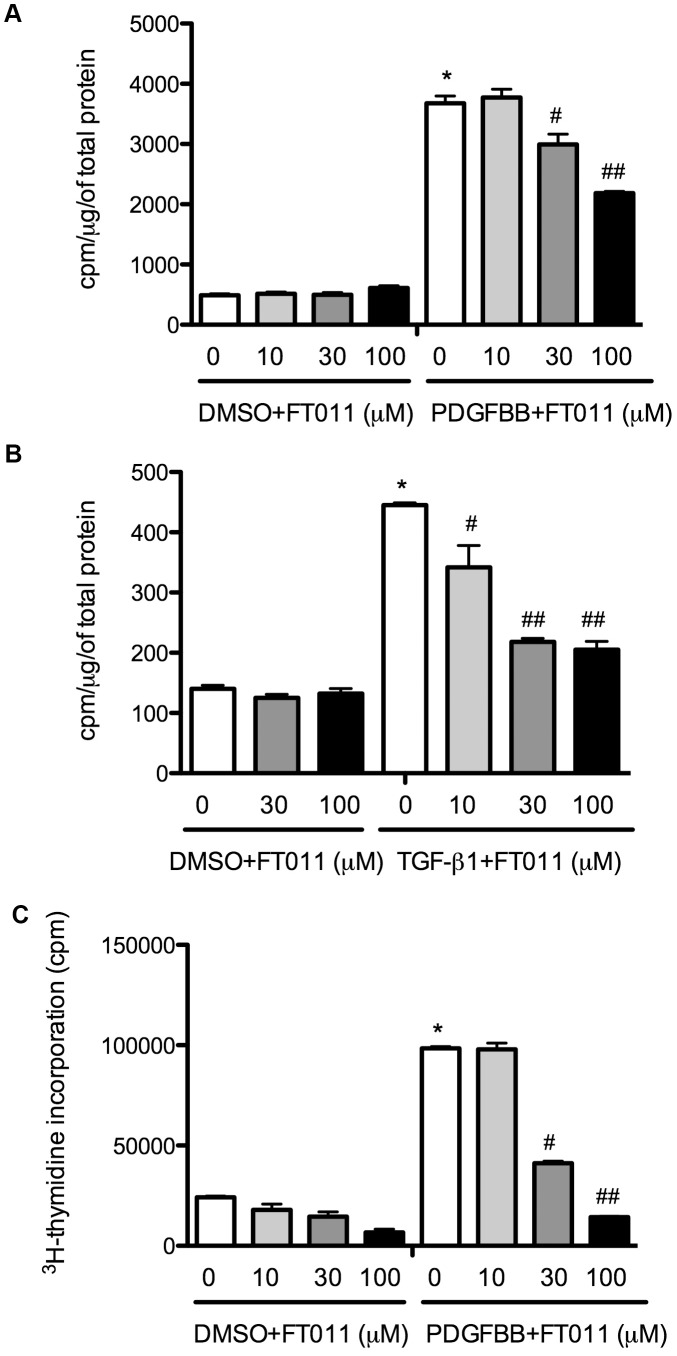

3H-proline and 3H-thymidine incorporation.PDGF BB (Figure 1A) or TGF-β1 (Figure 1B) stimulated collagen production in cultured mesangial cells with and without FT011 treatment as assessed by 3H-proline incorporation. Data are expressed as mean ± SEM. *p<0.001 versus DMSO with or without FT011 (10, 30 or 100 µM), #
p<0.01 versus PDGFBB or TGF-β1 and ##
P<0.01 versus PDGFBB with FT011 (30 µM) or TGF-β1 with FT011 (10 µM). PDGF-BB stimulated DNA synthesis in cultured mesangial cells (Figure 1C) with and without FT011 treatment as assessed by 3H-thymidine incorporation. Data are expressed as mean ± SEM. *p<0.001 versus DMSO with or without FT011 (10, 30 or 100 µM), #
p<0.01 versus PDGF-BB, ##
P<0.01 versus PDGFBB with FT011 (30 µM).